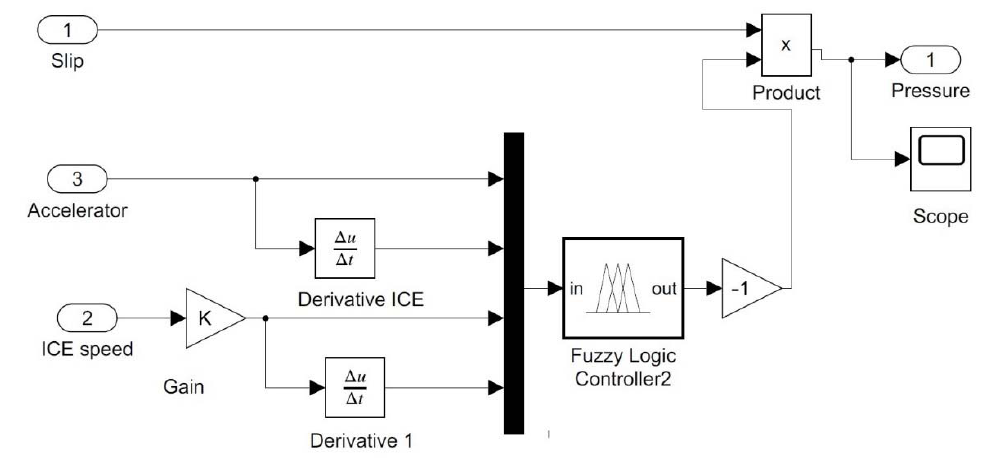
Figure 8. Fuzzy logic controller.